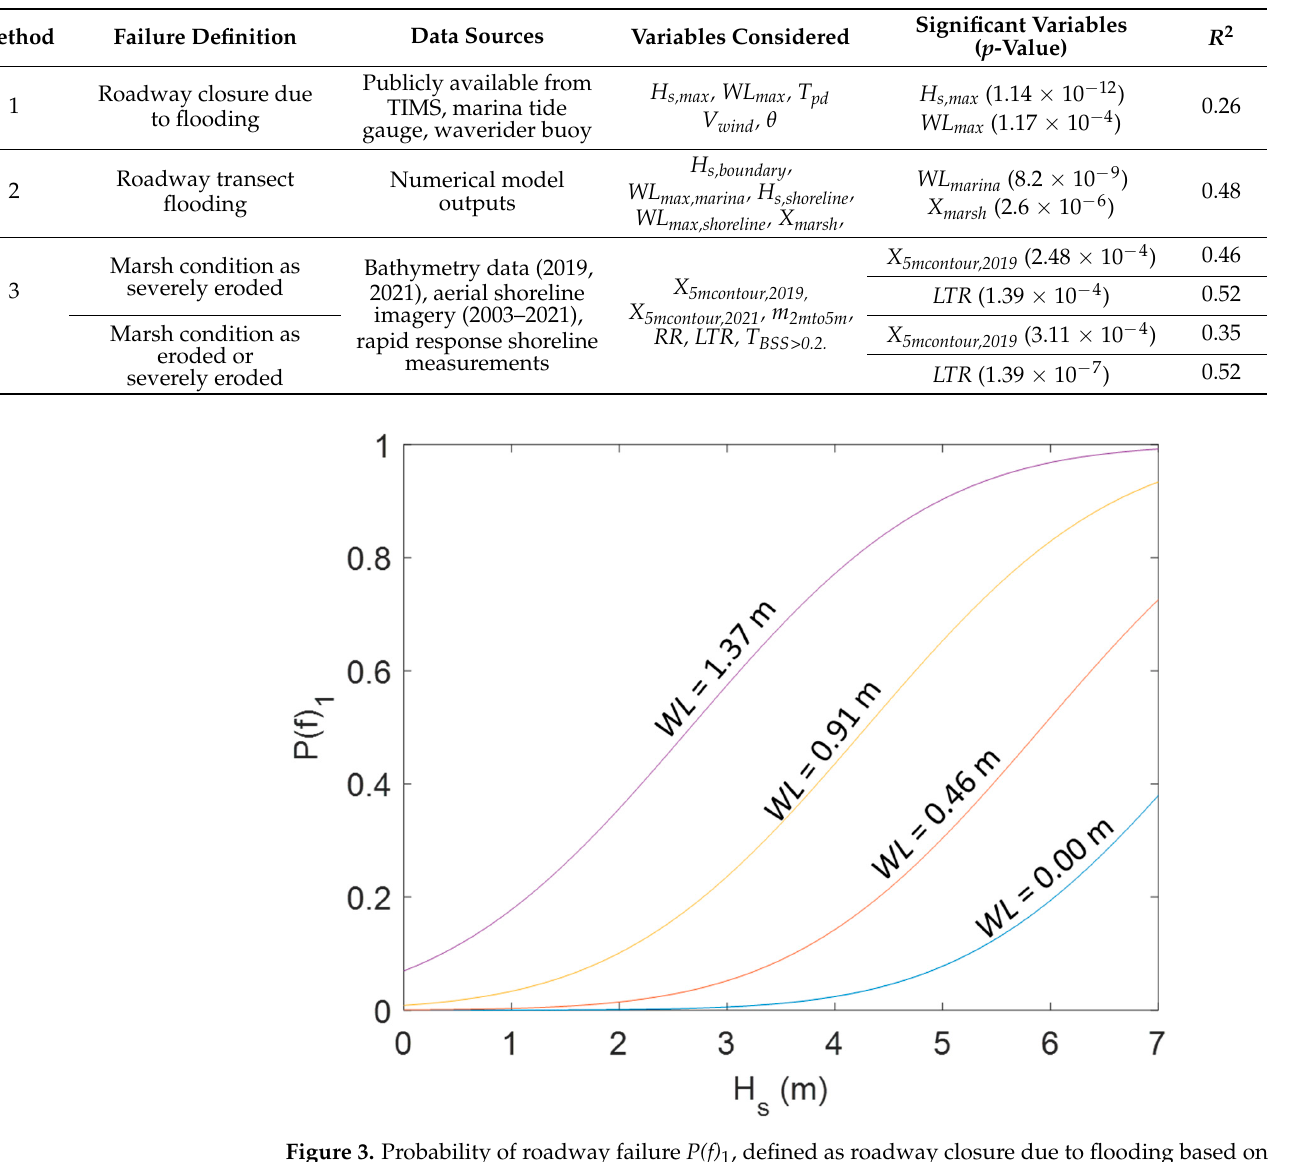
Figure 3. Probability of roadway failure P(f) 1 , defined as roadway closure due to flooding based on TIMS data, as a function of peak significant wave height H s,max (waverider buoy) for four peak water levels (NAVD88, marina tide gauge).